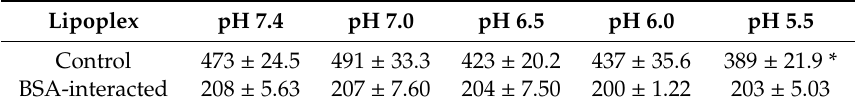
Table 1. Changes in particle size of lipoplex by pH.